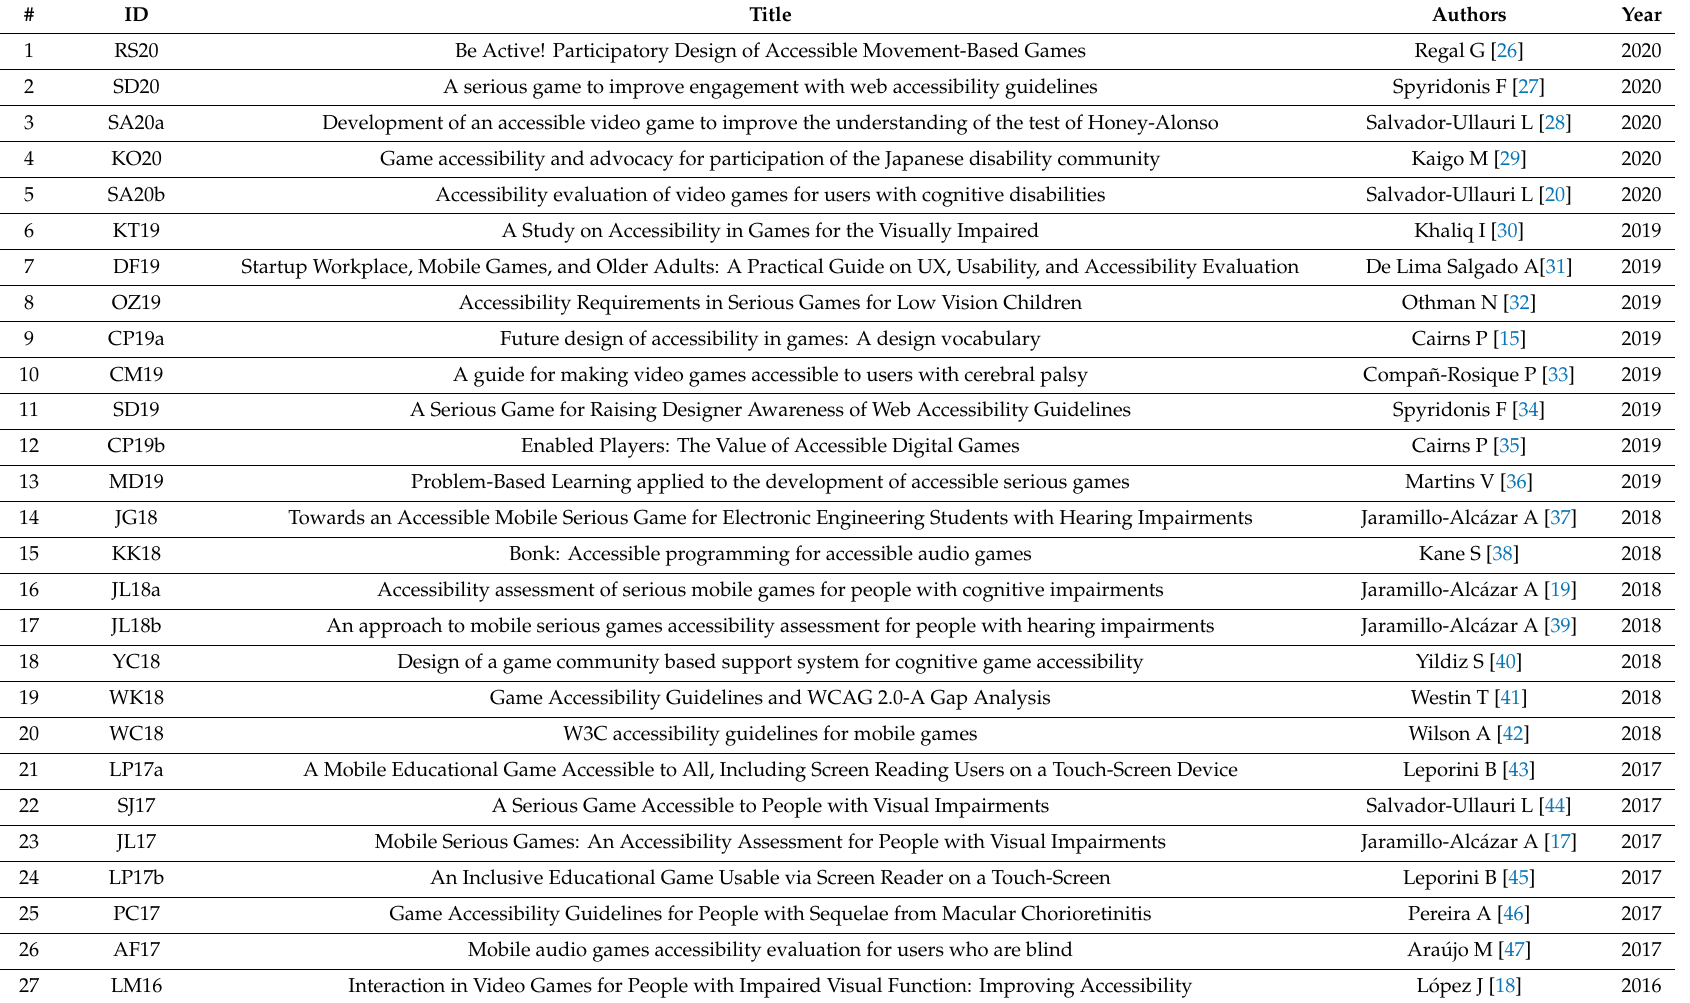
Table 3. List of papers selected in this